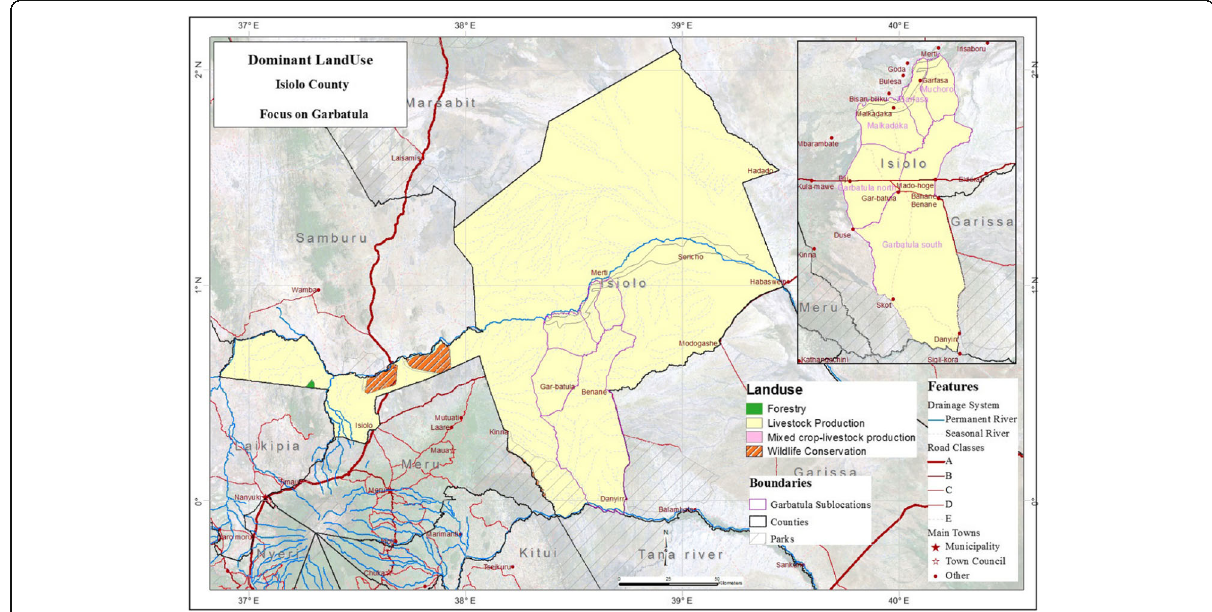
Figure 2 Land use categories in the research sites in Isiolo County, northern Kenya. Source: Centre for Research and Training in ASAL Development (CETRAD)